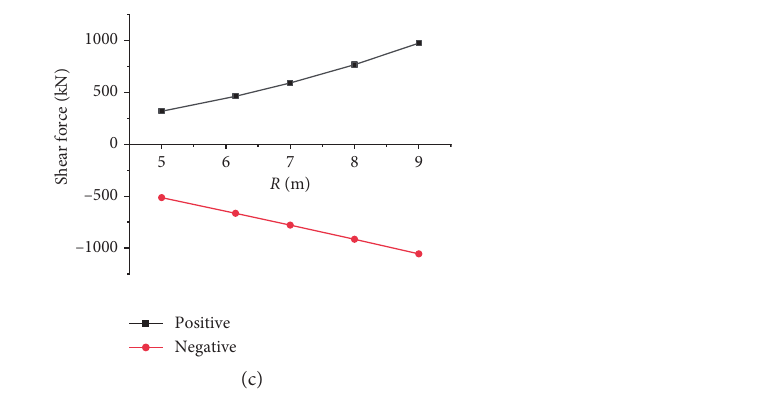
Figure 25: Variations of largest magnitudes of internal forces with R: (a) bending moment; (b) axial force; (c) shear forcel.